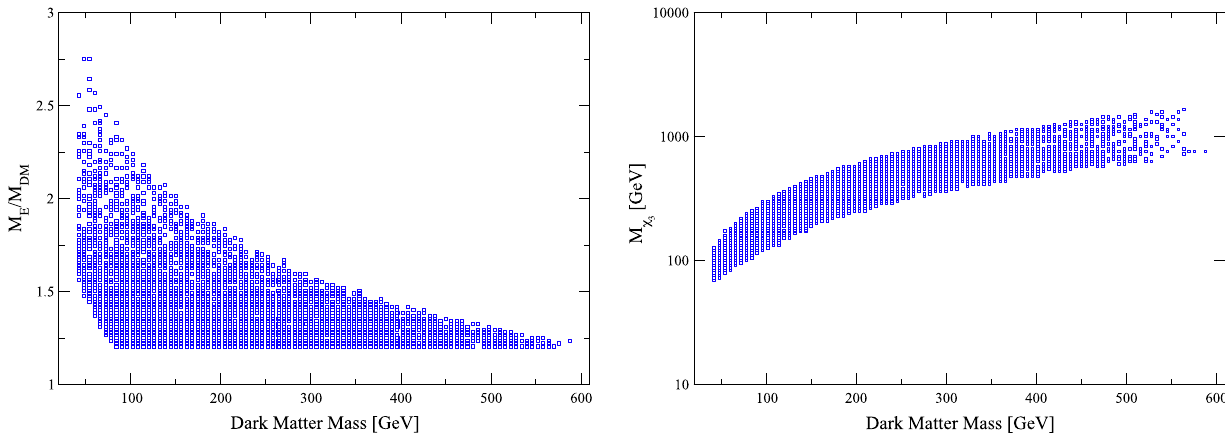
Fig. 5 Left: the viable models projected onto the plane ( m φ , m χ ( φ ). Right: the viable models projected onto the plane ( m φ , m χ